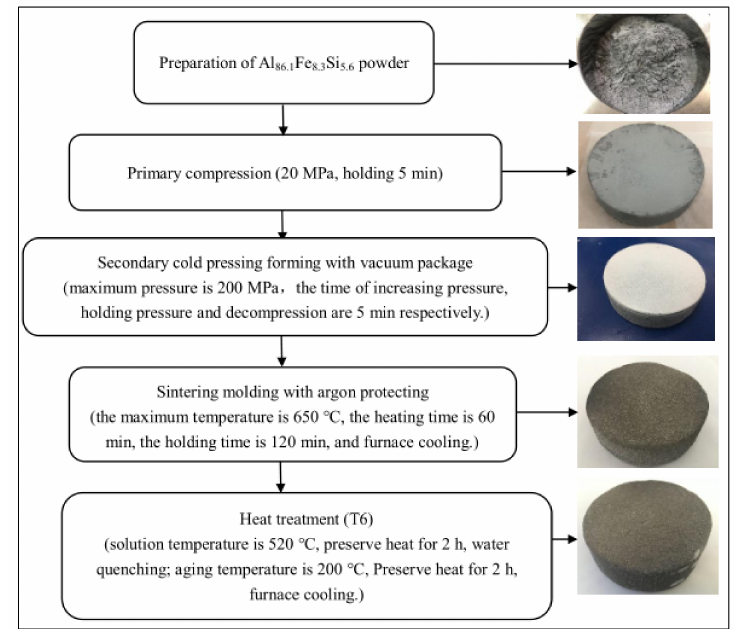
Figure 11. Preparation of the AlFeSi